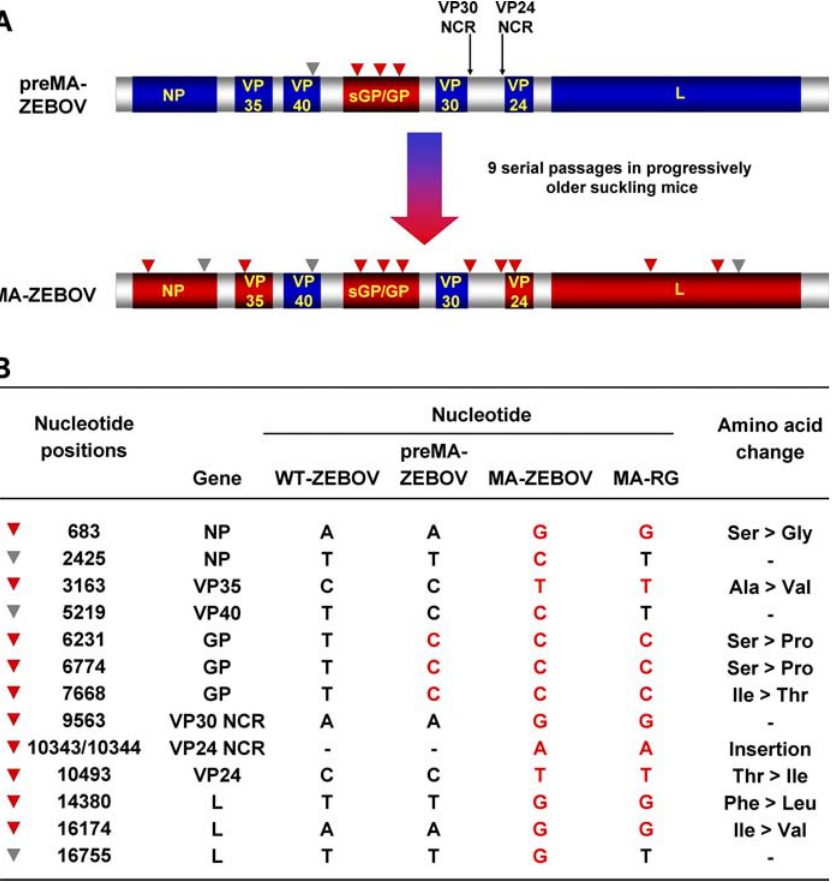
Figure 1. Molecular Differences among ZEBOV Mouse-Adapted Variants (A) Comparison of ZEBOV variants. Pre–MA-ZEBOV differs from wild-type ZEBOV (WT-ZEBOV) by three amino acids in the GP (red triangles) and a silent mutation in the ORF of the VP40 gene (gray triangle). Serial passage of pre–MA-ZEBOV in progressively older mice yielded MA-ZEBOV [14], which contains coding changes in the NP, VP35, VP24, and polymerase (L) (all shown in red triangles). Two nucleotide changes localize to the NCRs at the 3 9 end of the VP30 and the 5 9 end of the VP24 gene (red triangles); the remaining three modifications in the NP, VP40, and L ORFs are silent (gray triangles). (B) Nucleotide and amino acid differences among WT-ZEBOV, pre–MA-ZEBOV, MA-ZEBOV, and MA-RG. The nucleotide changes in GP of pre–MA-ZEBOV, compared to WT-ZEBOV, as well as the changes acquired during adaptation of pre–MA-ZEBOV in mice are shown in red. (cid:1) , no change. DOI: